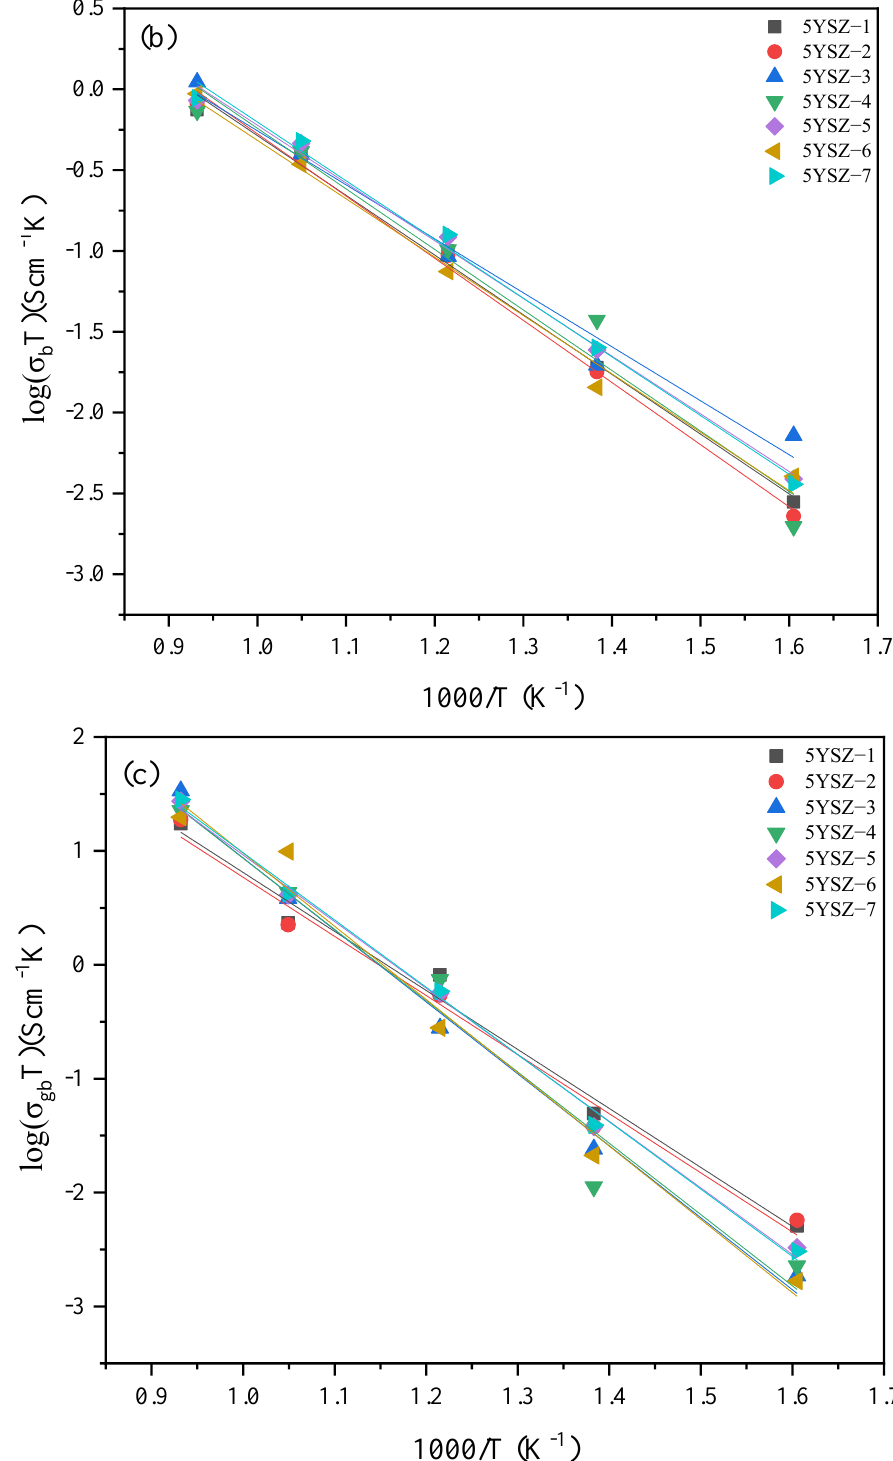
Figure 9. ( a ) Total conductivity, ( b ) grain conductivity, ( c ) grain boundary conductivity of seven 5YSZ ceramics.